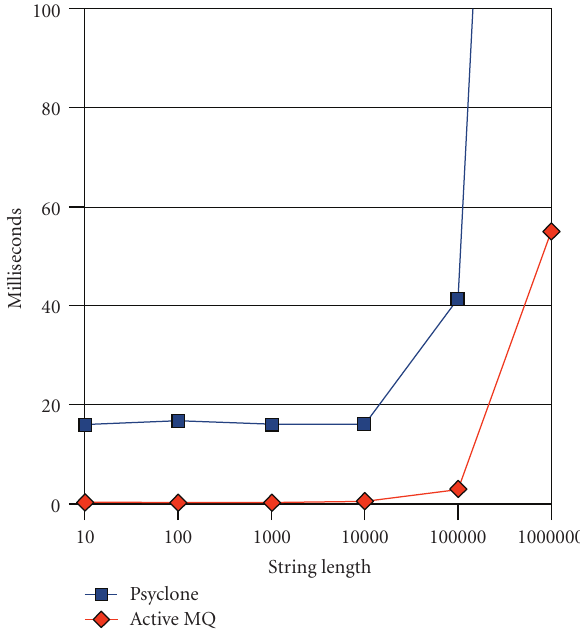
Figure 24: Round-trip message routing times as a function of message